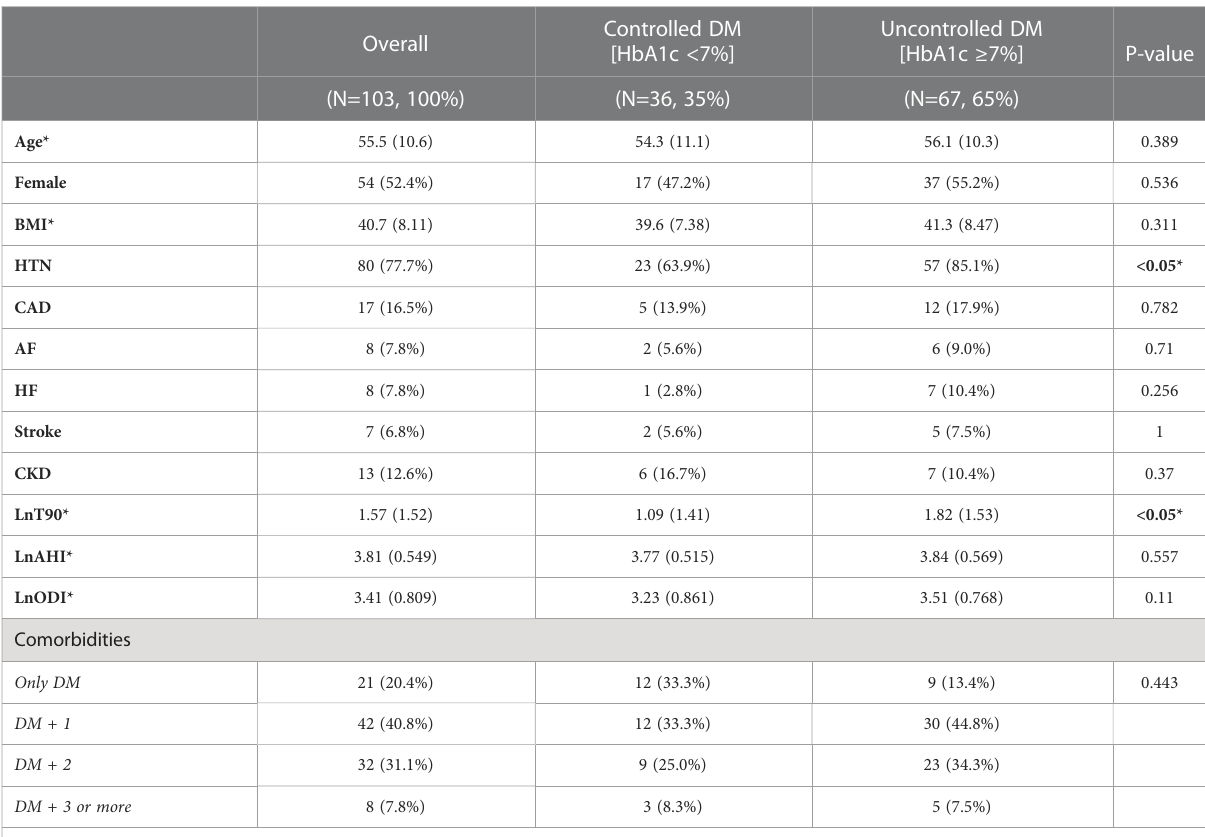
TABLE 1 Population characteristics.